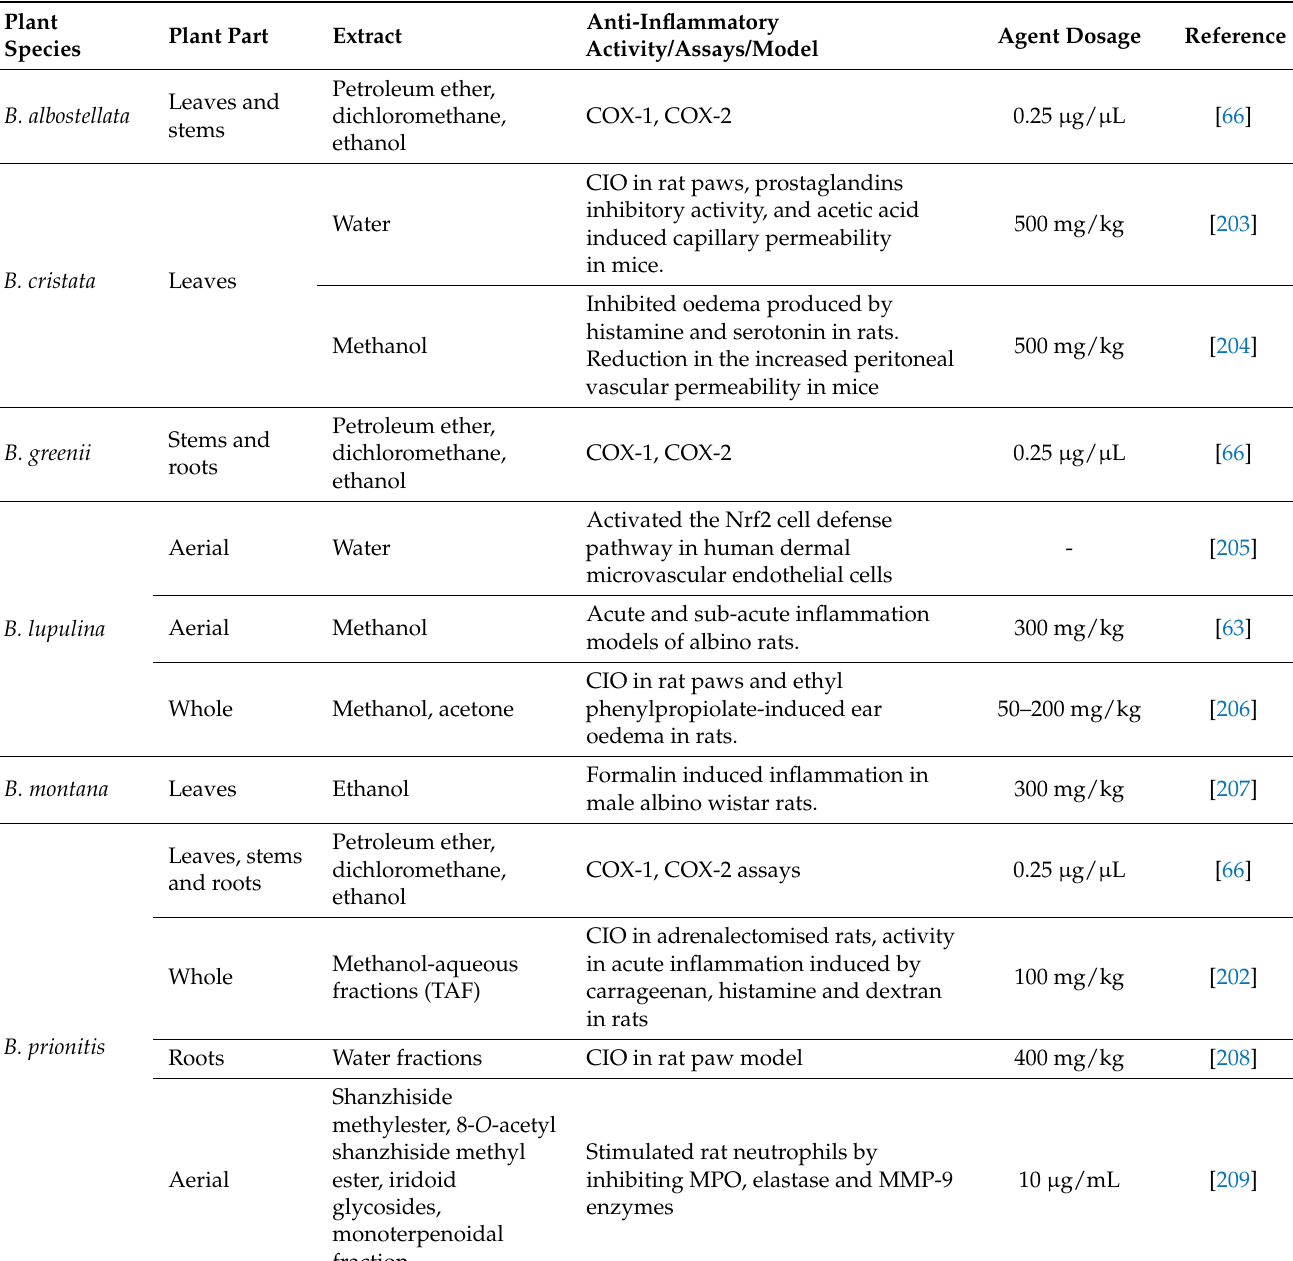
Table 5. Anti-inflammatory activities of extracts, fractions and isolated compounds from species within Barleria